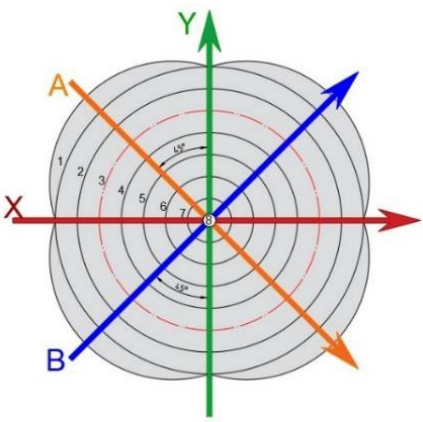
Figure 6. The definition of fiber intersection angle N after drawing and curing.